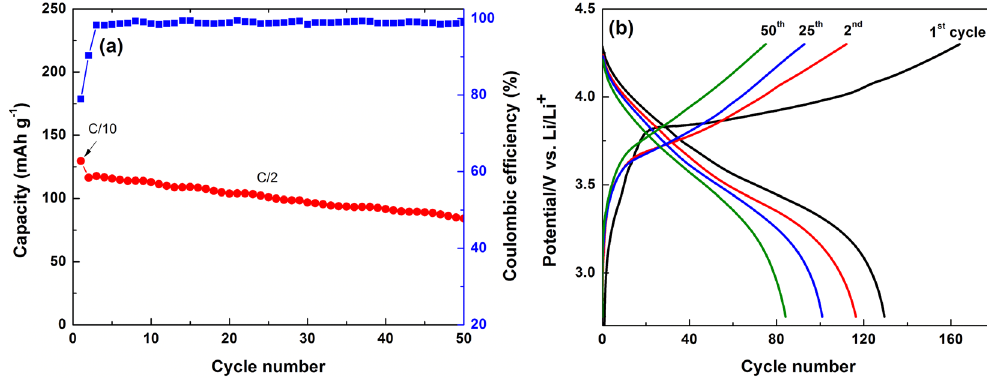
Figure 7. ( a ) Cycling performance of full cells employing gSi@C anode and LiCoO 2 cathode for 50 cycles. ( b ) The corresponding galvanostatic charge-discharge curves of the full